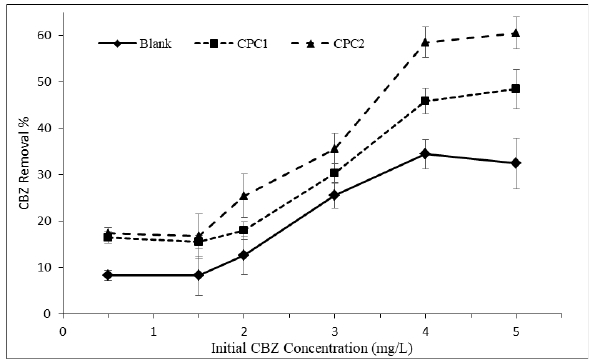
Figure 4: Effect of initial CBZ concentrations on removal